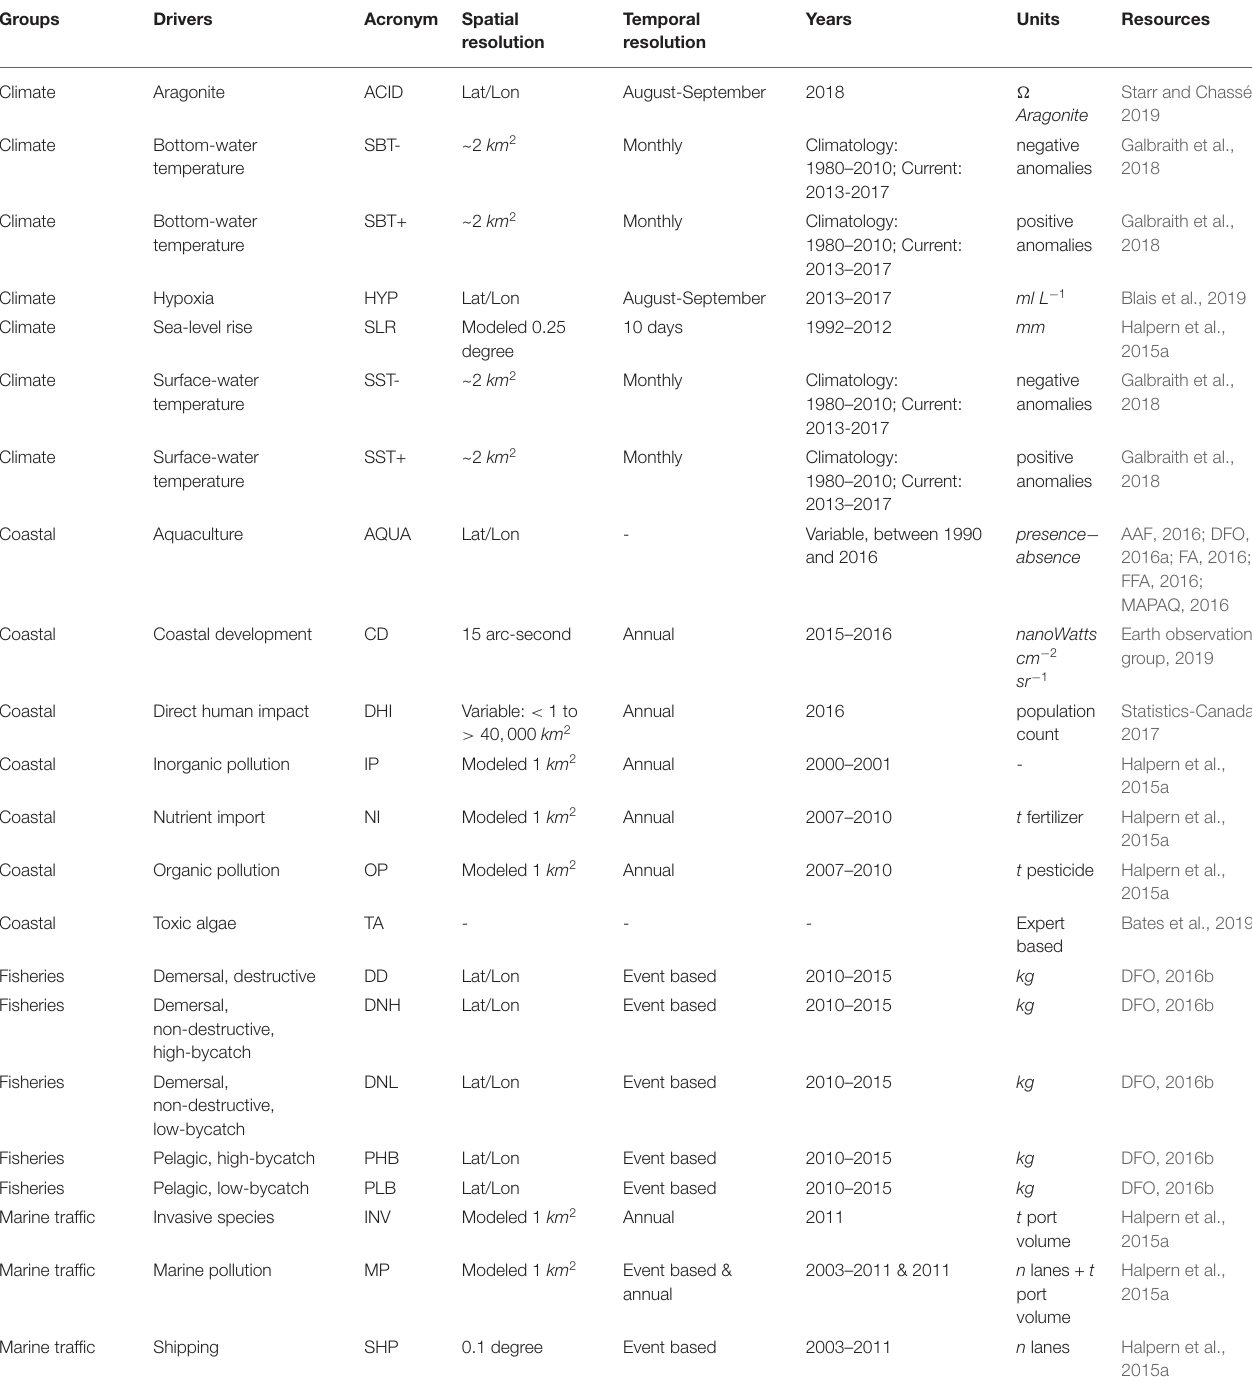
TABLE 1 | List of drivers available on eDrivers and used for the analyses presented in this paper. Further details on methods and data are available in the Supplementary Materials .